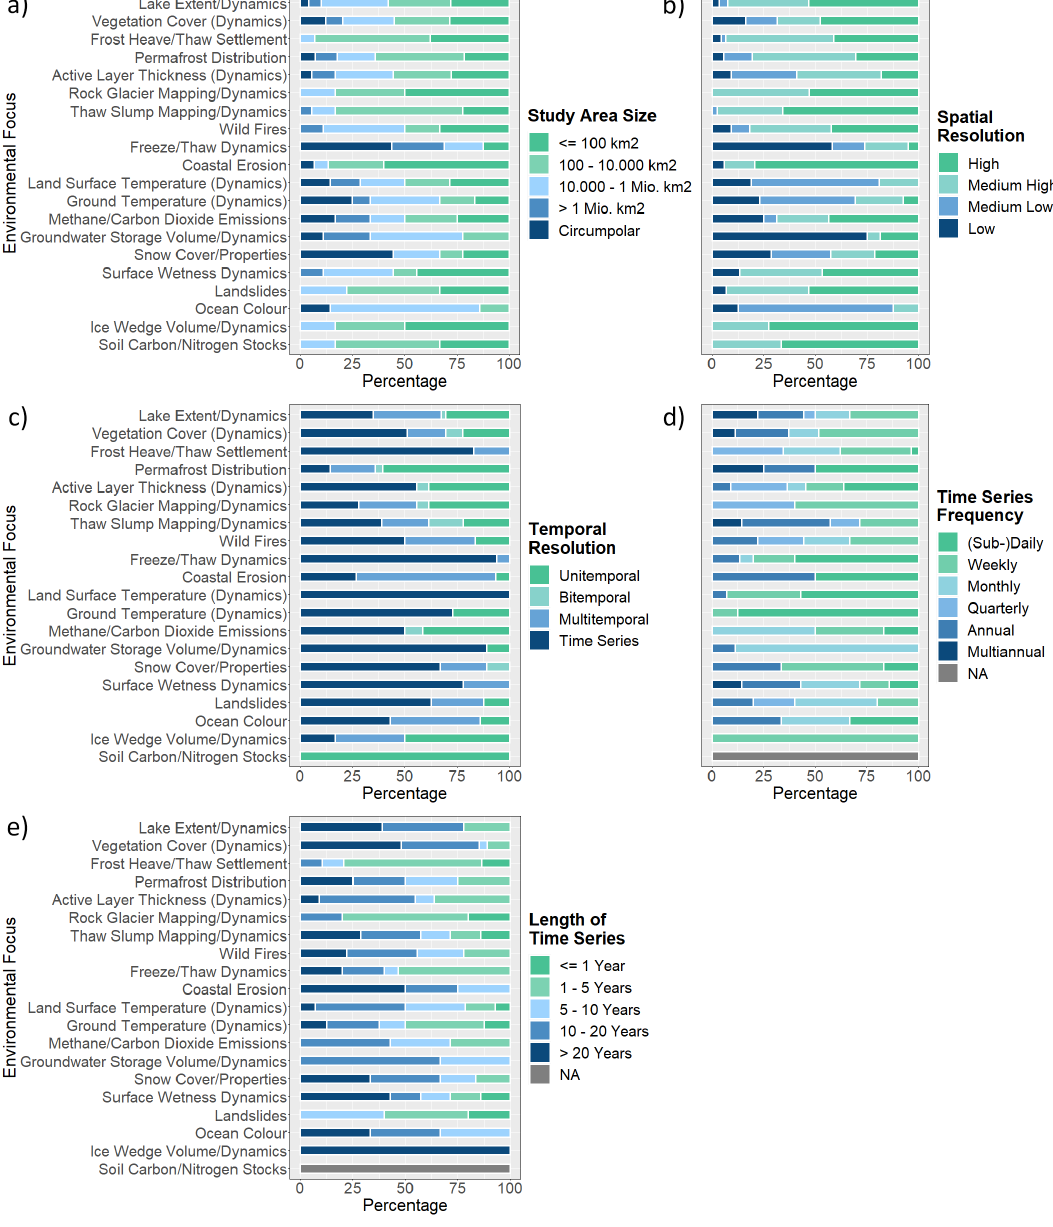
Figure 12. Distribution of spatial and temporal resolutions for the top 20 most frequent environmental topics within the reviewed articles. The y-axis is order by topic frequency. ( a ) Size of the study area. ( b ) Spatial resolution that is either high more time steps are used it is considered a time series within this review. ( d ) Temporal resolution applied within time series studies. ( e ) Length of time series for studies that conducted a time series